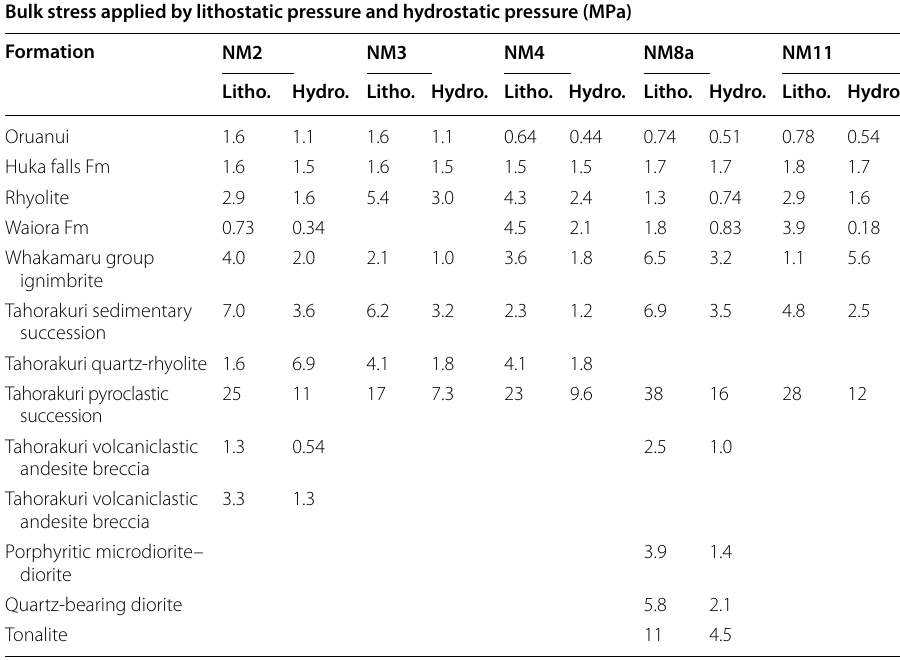
Table 8 Bulk lithostatic and hydrostatic stress applied to each formation Bulk stress applied by lithostatic pressure and hydrostatic pressure (MPa) Formation NM2 NM3 NM4 NM8a NM11